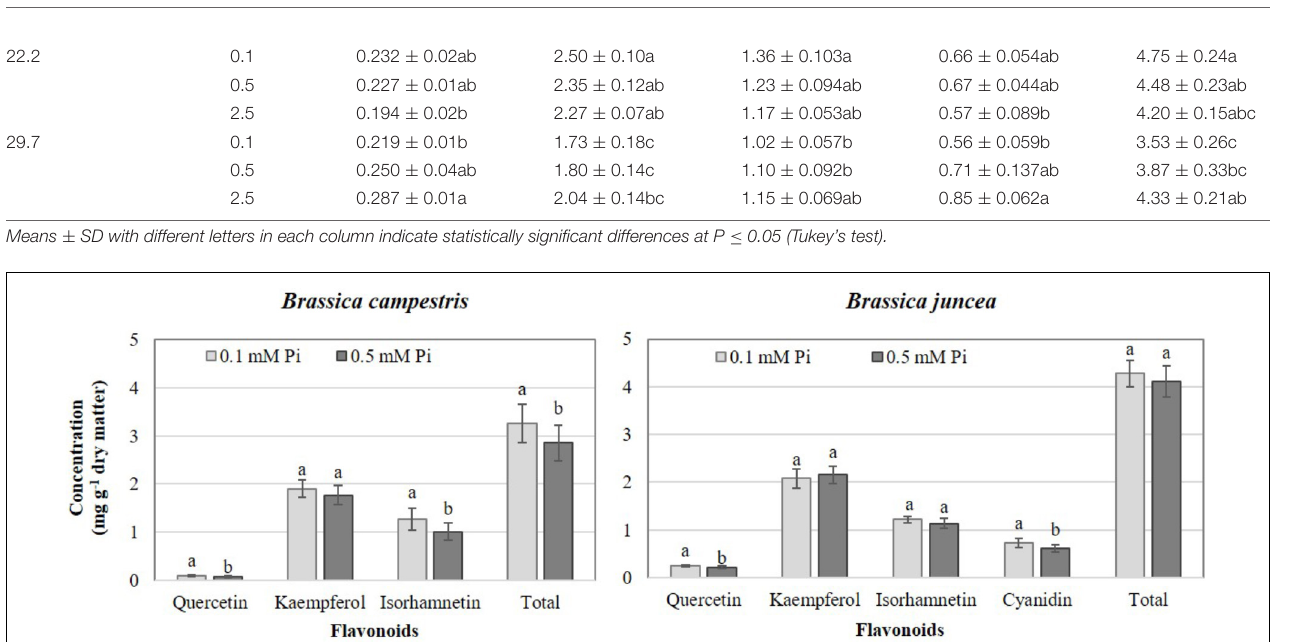
TABLE 1 | Mean daily photosynthetically active radiation (PAR) and phosphite (Phi) affecting flavonoid concentration (mg g − 1 dry matter) in B. juncea cv. Red Giant. PAR (mol m − 2 )